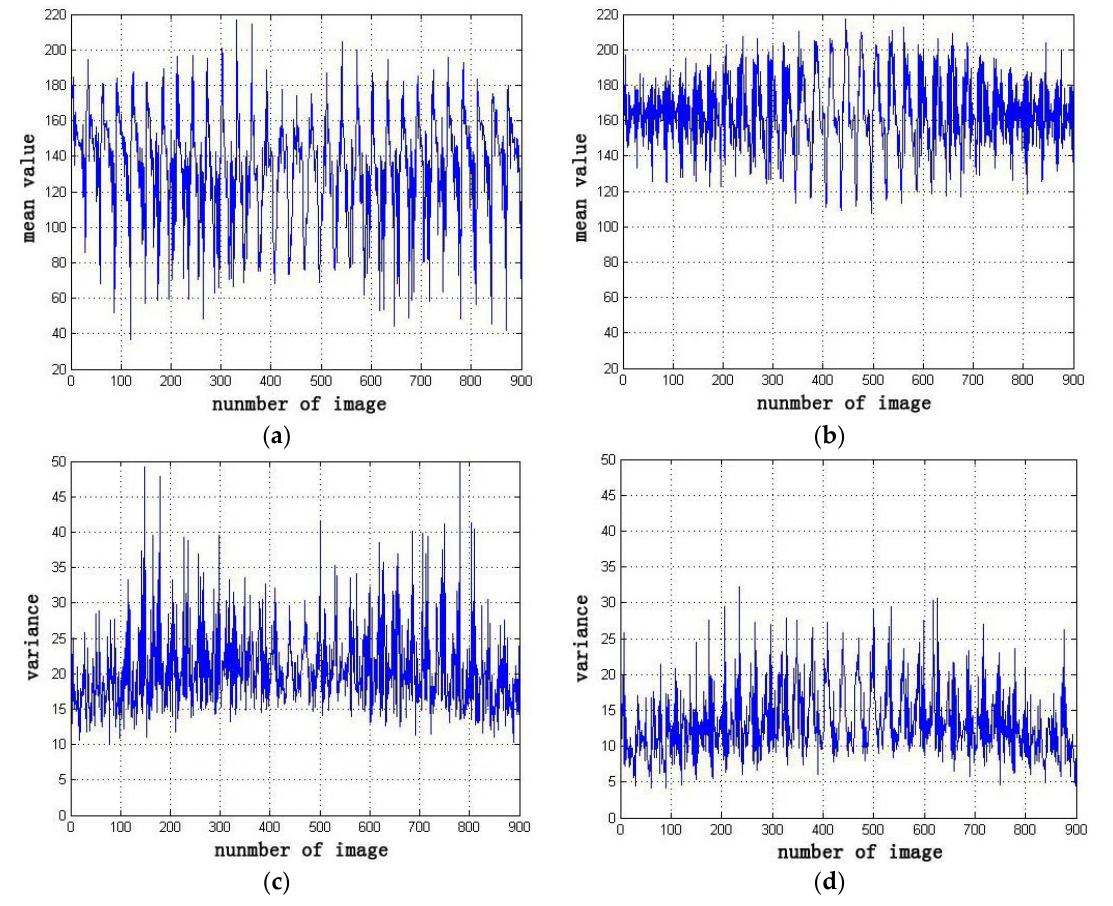
Figure 13. Distribution curve of the mean and standard deviation of the original images and those processed using the Wallis dodging method: ( a ) mean of the original images; ( b ) mean of the images processed using the Wallis dodging method; ( c ) standard deviation of the original images; and ( d ) standard deviation of the images processed using the Wallis dodging method.